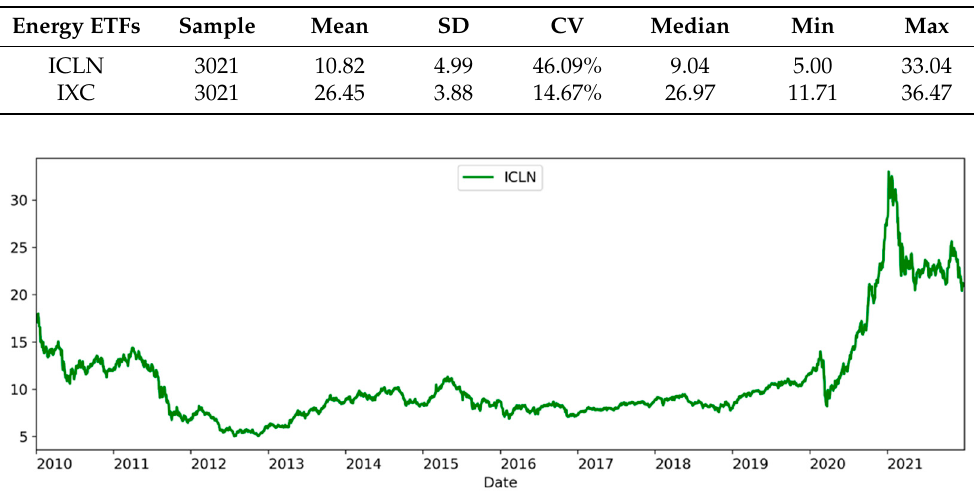
Figure 2. The trend of the iShares Global Clean Energy ETF (ICLN) prices from 2010 to 2021.